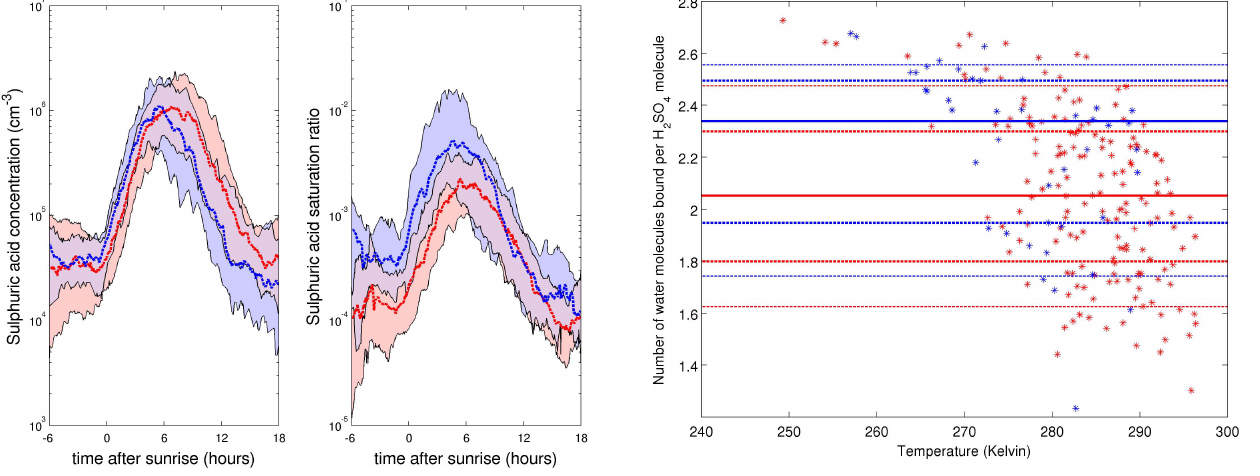
Fig. 6. (a) Median sulfuric acid concentration (modeled, SOSA) on overcharged days (red) and undercharged days (blue). (b) Median sulfuric acid saturation ratio (modeled, SOSA) on overcharged days (red) and undercharged days (blue). The 25th to 75th percentiles are represented by the filled areas. In this picture, the summer months have been removed.